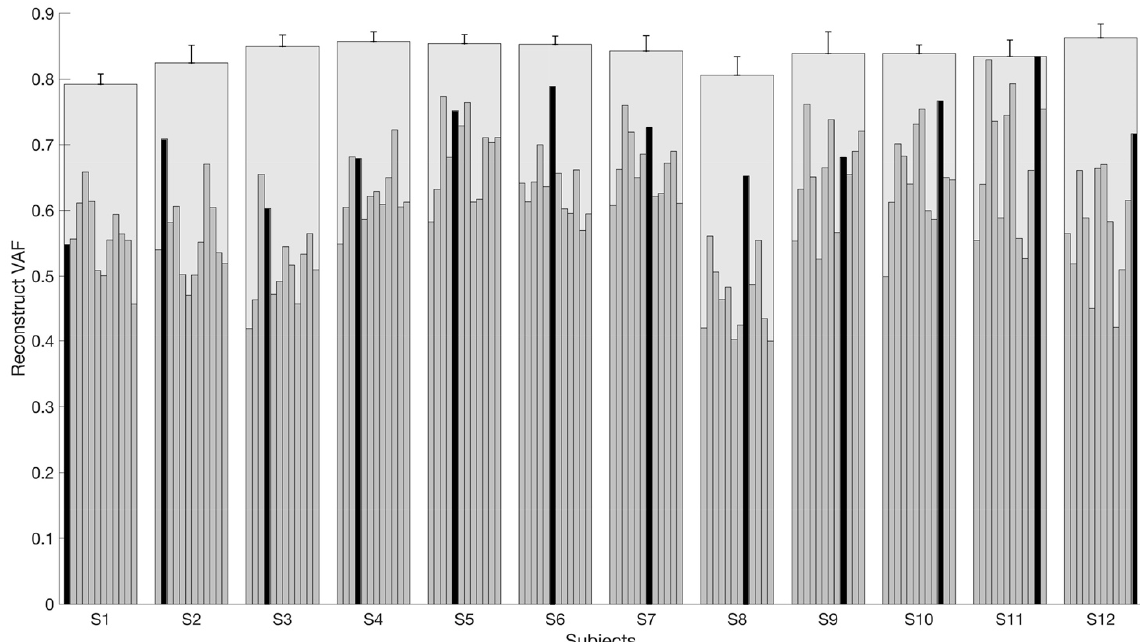
Figure 11. Reconstruction of VAF (rVAF) for the inter-subject condition. Four synergies were extracted from each subject and each repetition. The average synergies across repetitions for each subject were fixed to compute the rVAF of inter-subject (the rVAF that it was possible to reconstruct for each subject by using synergies extracted from other subjects). The thin gray bars indicate the mean rVAF for all the inter-subject possible pairs; meanwhile, the black bar indicates the rVAF that the mean intra-subject muscle activations can be reconstructed using the synergies extracted from the same subject. The wide gray bars are the average VAF across repetitions of each subject (using each task and subject-specific set of synergies).